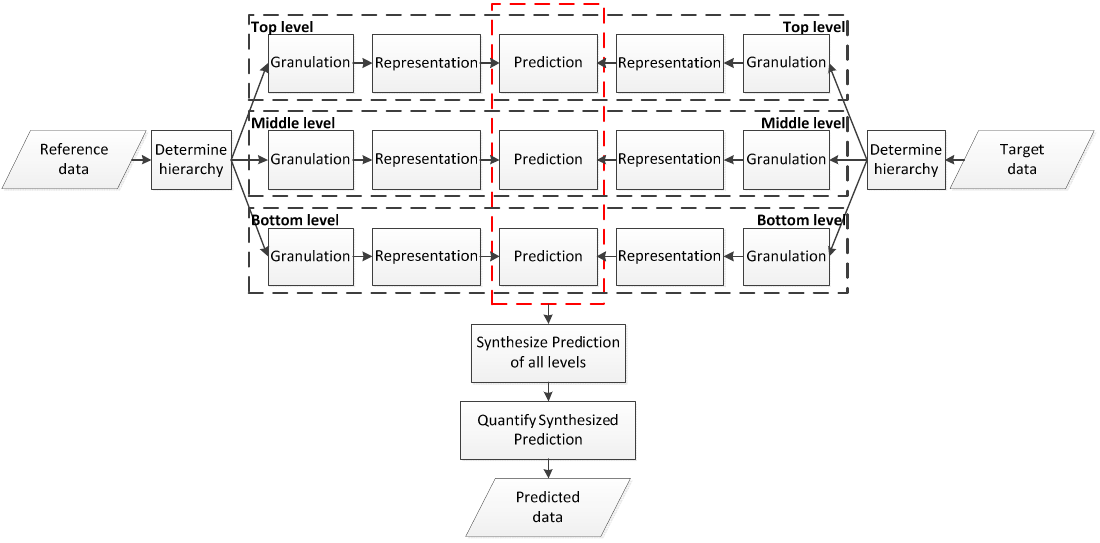
Figure 5. A schematic view of wind speed data interpolation and extrapolation based on the granular computing method.